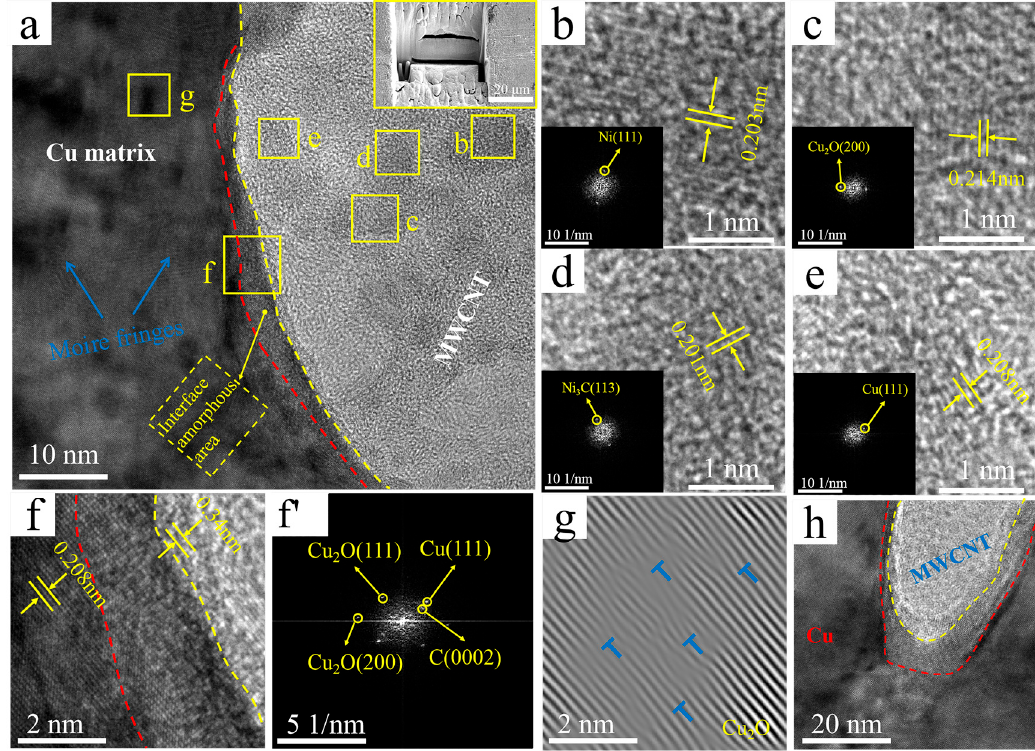
Figure 8. TEM images of the Ni&Cu@CNTs/Cu composite: ( a ) interface, upper right inset shows manipulator sampling (Illustration is TEM sampling location); ( b – e ) the enlarged image of the corresponding region in ( a ) (The illustration is the corresponding FFT image); ( f , f’ ) enlarged and IFFT images of region in ( a ); ( g ) IFFT image of region g in ( a ), with dislocations marked by “T” symbols; ( h ) interface at the end of MWCNT.